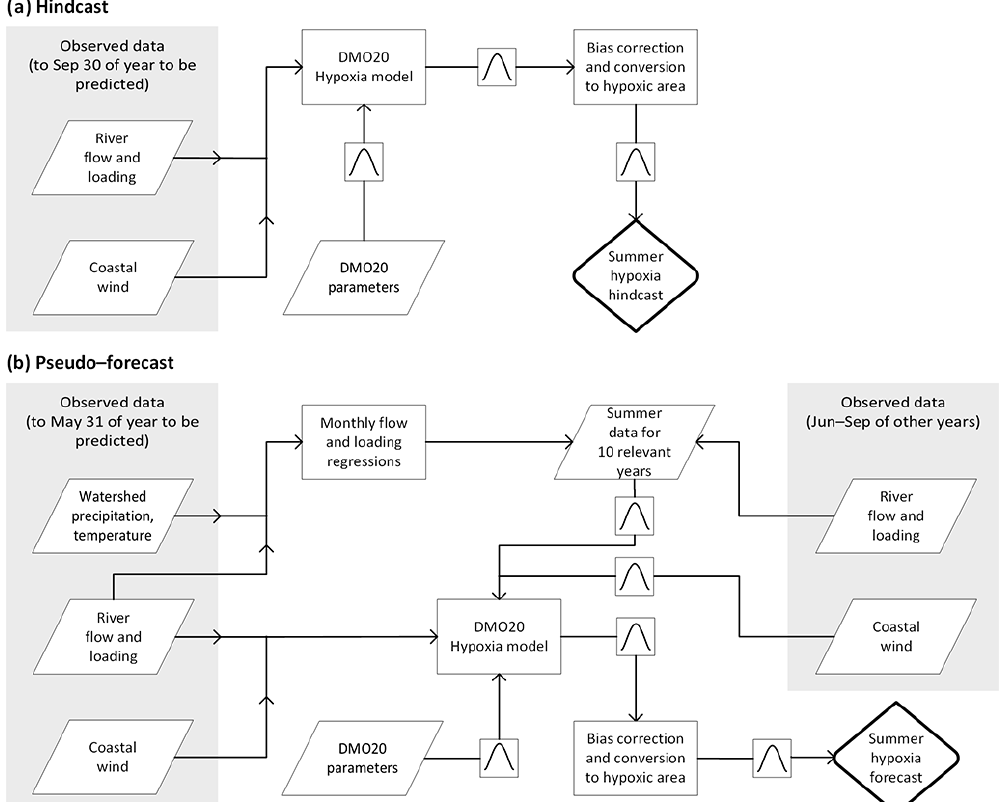
Figure 2. Flowchart summarizing processes and inputs required to generate the hypoxia hindcast (a) and pseudo-forecast (b) for a given year. Parallelograms represent data inputs and Bayesian posterior parameter distributions. Rectangles represent forecasting computations, and squares with bell-shaped curves indicate steps that propagate uncertainty (including stochastic